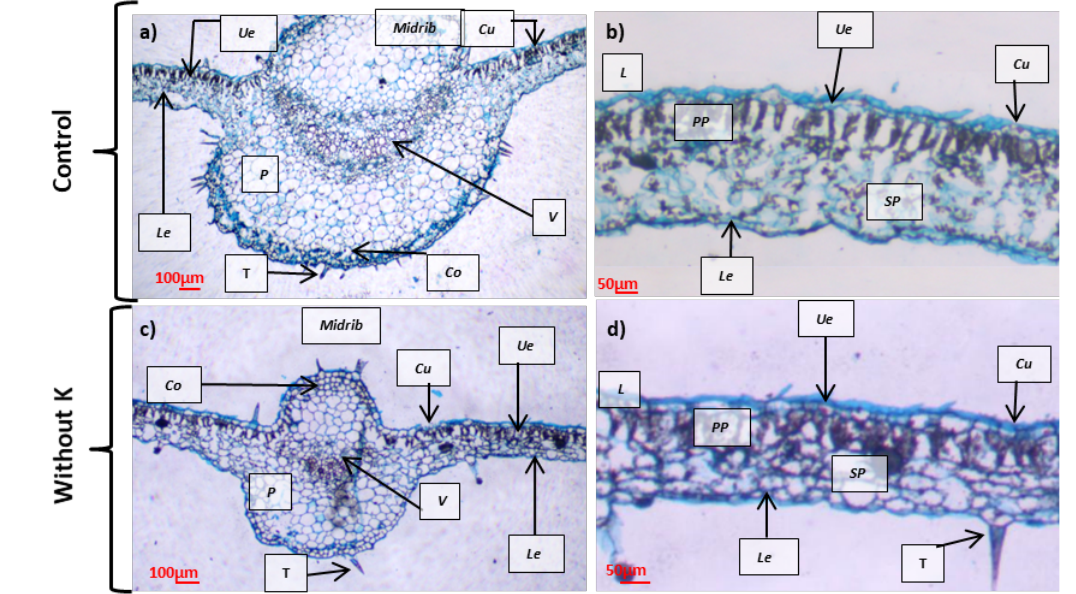
Fig. 4: Cross-sections of leaves in the tree tomato plants at 135 dat. Control plants (without deficiencies) (a, b) and plants grown without K (K deficiency) (c, d). Midrib (a, c), same magnification, Bar = 100 μm. Leaf blade (b and d), same magnification, Bar = 50 μ m. P : parenchyma; V : vascular bundles; 381 Co : Colenquima; Midrib: rib; PP : palisade parenchyma; SP: spongy parenchyma, Ue : Upper epidermis, Le : Lower Epidermis, T: trichomes, and Cu: cuticle.